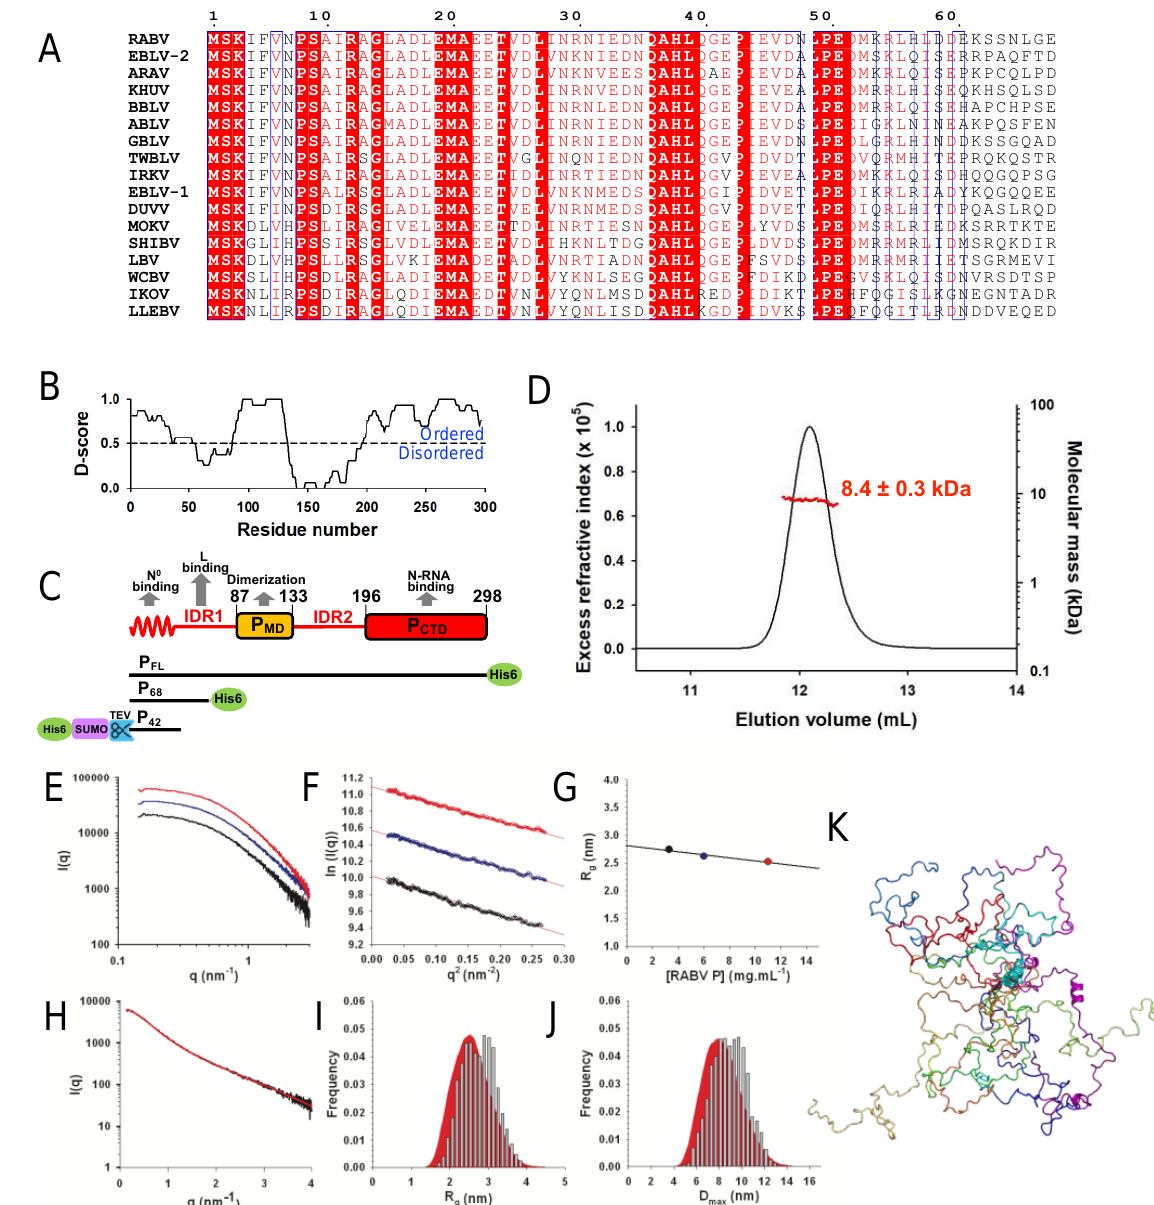
Figure 1. The N 0 chaperone module of RABV phosphoprotein. ( A ) Multiple sequence alignment of Lyssavirus P NTR region. Members of the Lyssavirus genus and their UniProt accession number: RABV—rabies virus CVS − 11 strain P22363, EBLV − 1—European bat lyssavirus 1 A4UHP9, EBLV − 2—European bat lyssavirus A4UHQ4, ARAV—Aravan virus Q6X1D7, KHUV—Khujand virus Q6X1D3, BBLV—Bokeloh bat lyssavirus U3MZL8, ABLV—Australian bat lyssavirus Q9QSP3, GBLV—Gannoruwa virus A0A1J0RI70, TWBLV—Taiwan bat lyssavirus A0A3P8MNG3, IRKV—Irkut virus Q5VKP5, DUKV—Duvenhage virus O56774, MOKV—Mokola virus P0C569, SHIBV—Shimoni bat virus D4NRJ9, LBV—Lagos bat virus D4NRK4, WCBV—West Caucasian bat virus Q5VKP1, IKOV—Ikoma virus J5JWQ7, LLEBV—Lleida virus A0A1I9RG27. ( B ) D-score. A consensus disordered prediction (D-score) was calculated as described in [20]. The threshold to distinguish between the ordered and disordered region was arbitrarily set at 0.5. The shaded areas indicate the positions of the known folded dimerization domain (P MD ) and NC-binding C-terminal domain (P CTD ) (see panel C ). ( C ) Schematic representation of RABV phosphoprotein modular organization and constructs. The upper part shows the structural organization of the phosphoprotein. Boxes in- dicate the localization of folded domains, undulated lines the localization of predicted MoRE and lines the localization of intrinsically disordered regions (IDR 1 − 2). The grey arrows indicate the lo- cation of the regions associated with functions in RNA synthesis. The lower part shows the three